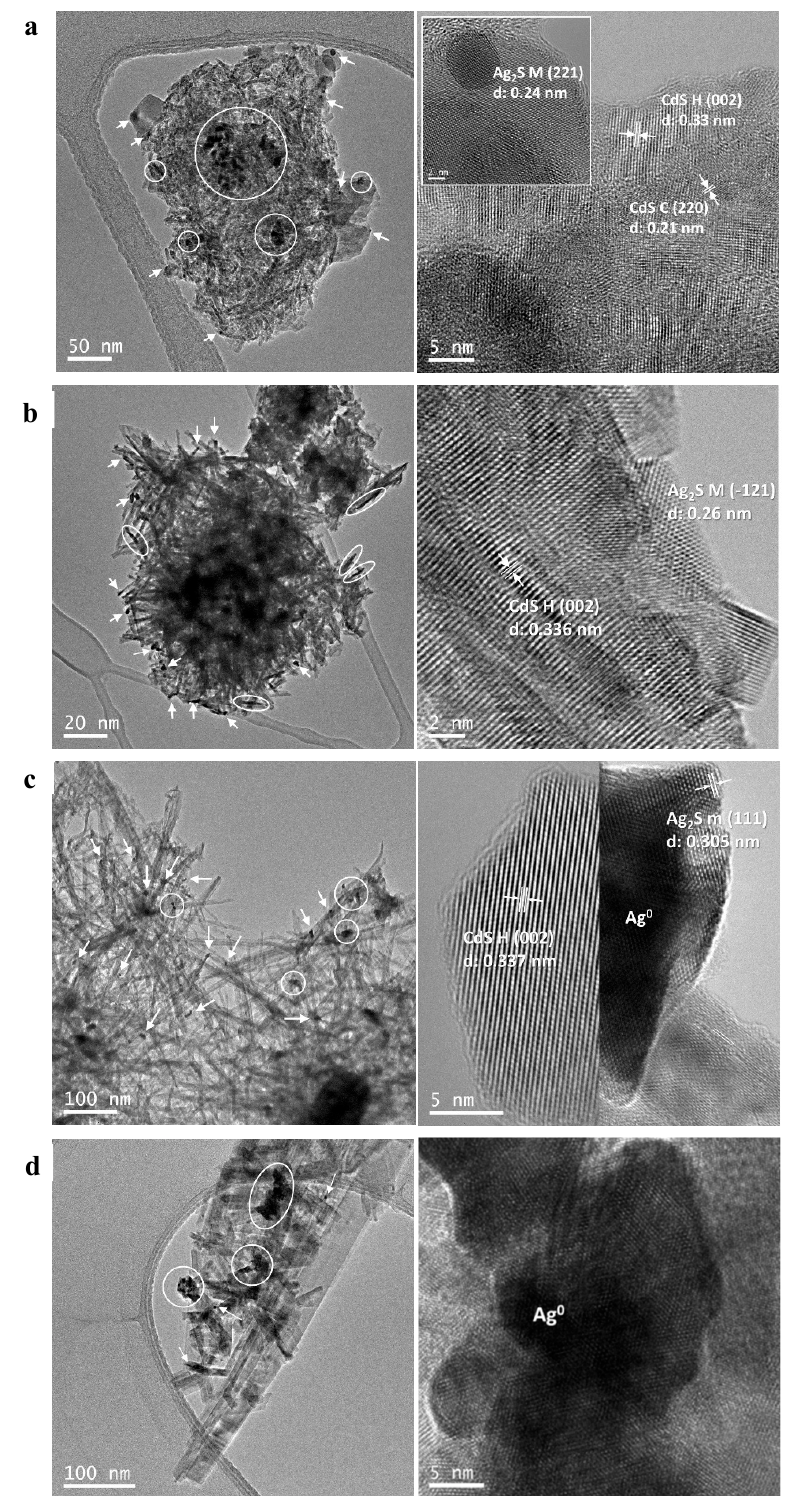
Figure 6. HR-TEM images of AgCdS-T samples: ( a ) T = 90 °C, ( b ) T = 120 °C, ( c ) T = 150 °C; and ( d ) T = 190 °C (Ag 2 S/Ag particles noted in images by arrows and circles).